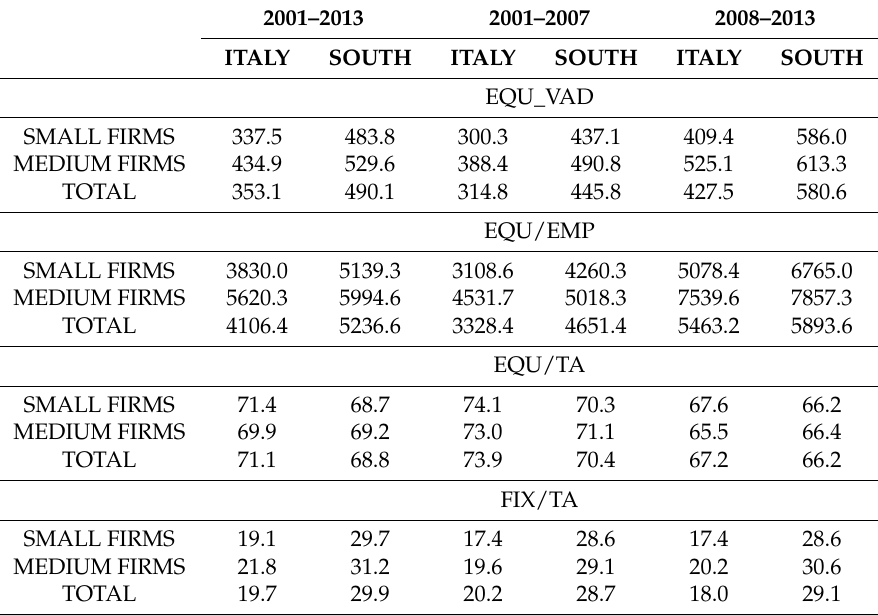
Table 2. Equity and asset structure ratios for sized classes (median